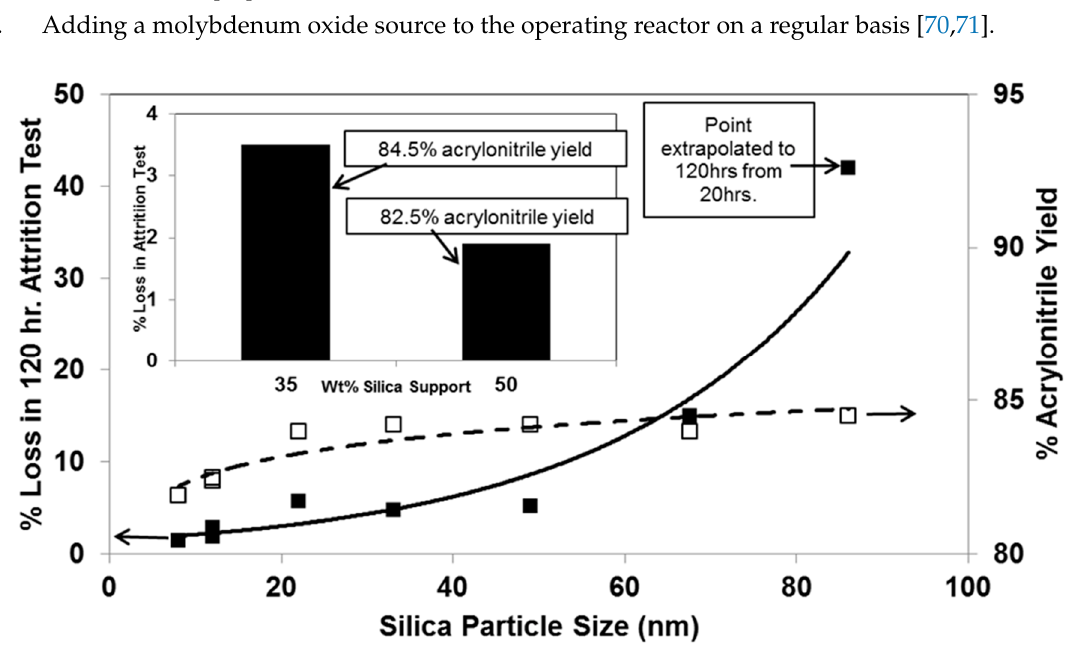
Figure 4. The effect of silica support particle size and amount on ammoxidation catalyst attrition resistance (hardness) and catalyst performance. See data source US Patent 7,473,666 for descriptions of attrition loss test and catalyst preparations. Insert shows data for identical catalyst composition supported on 12 nm silica at two support levels.